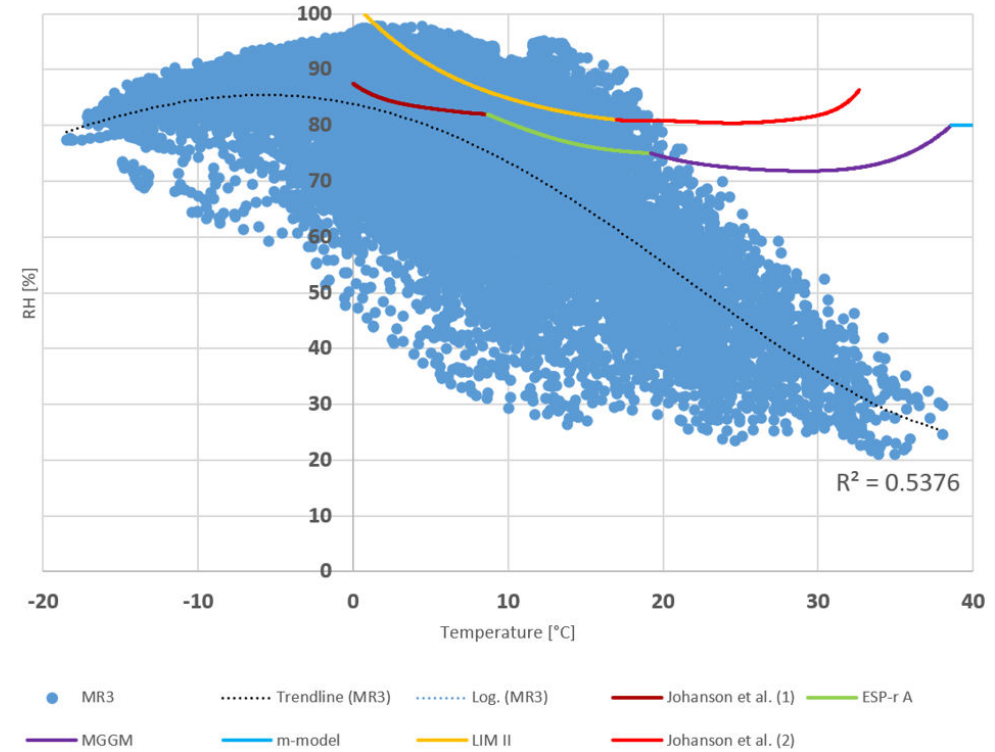
Figure 11. An example of visual summary of mould growth conditions for a sensor, here exemplified by the lower roof sensor on the ZEB Laboratory. A “trend line” is created to show the distribution of typical RH values for every temperature. Note that a substantial share of the data points exceed the criteria for the onset of mould growth, collected by Gradeci et al. [16]. This share for every monitoring point is summarized in Table